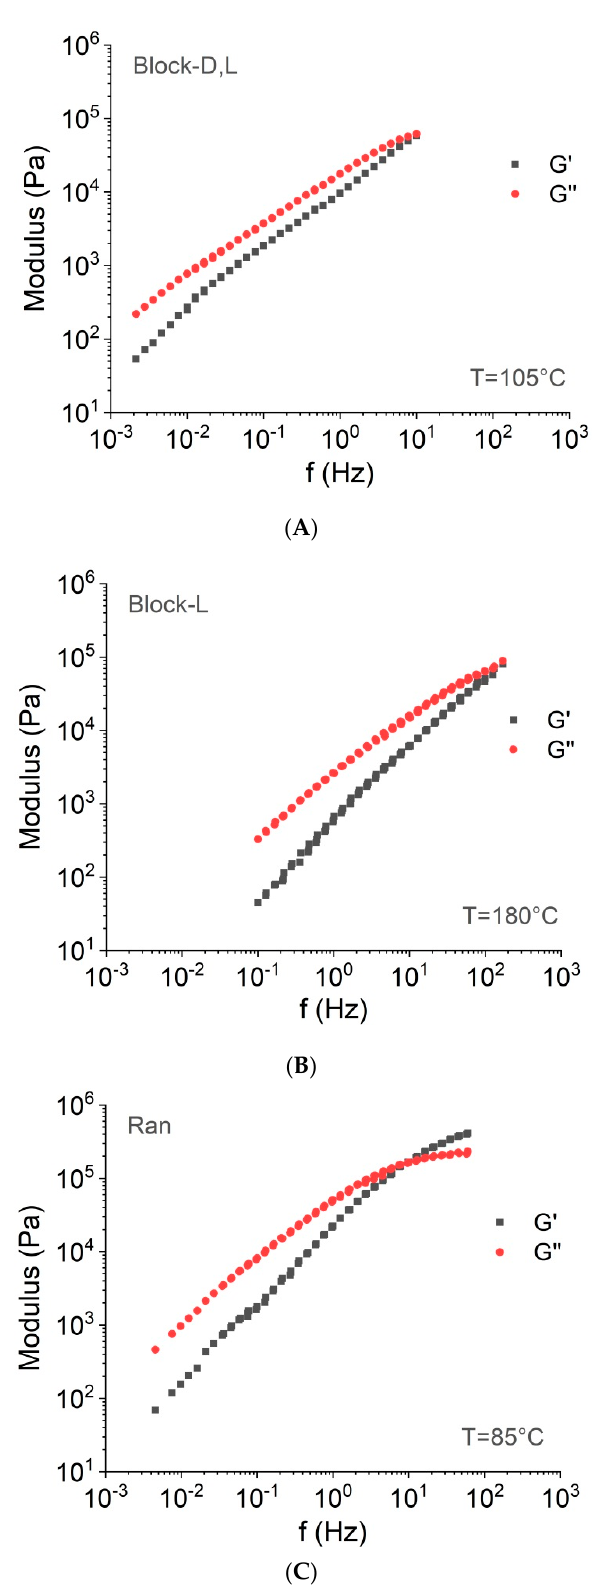
Figure 7. Evolution of the elastic (G’) and viscous (G’’) moduli as a function of frequency carried out at reference temperature and 0.1% of strain for ( A ) Block-D,L, ( B ) Block-L and ( C ) Ran samples.